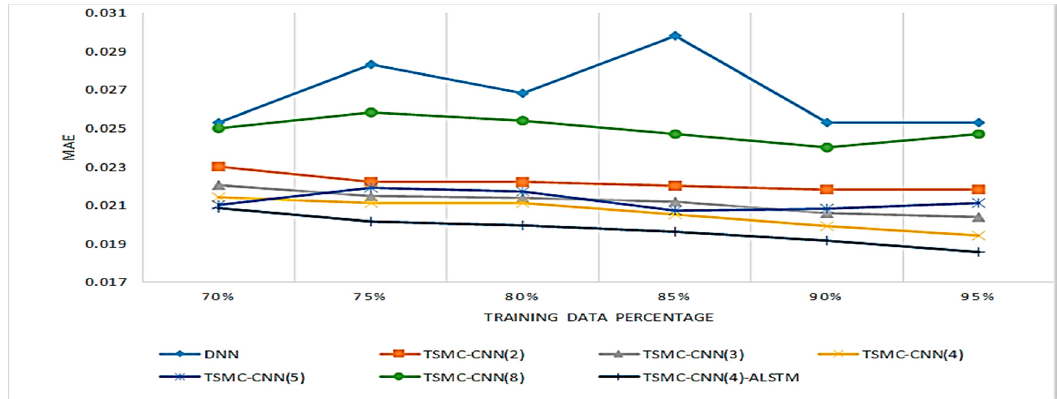
Figure 13. Comparisons of DNN, TSMC-CNN and TSMC-CNN-ALSTM with different numbers of channels in terms of the MAE.